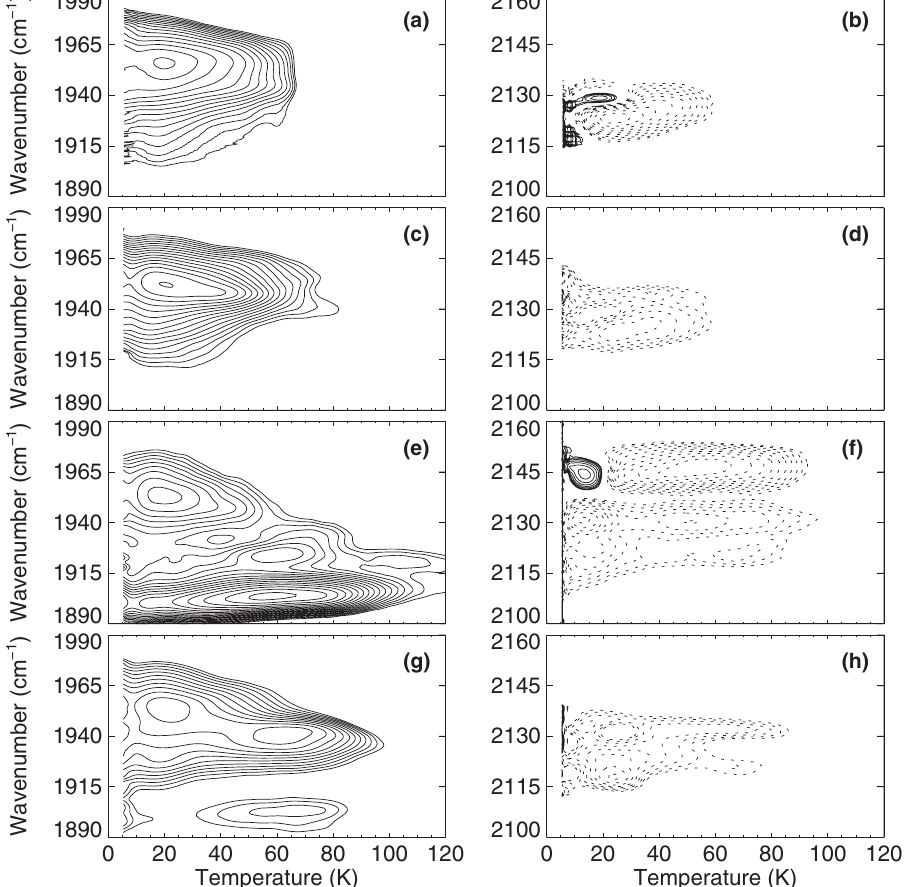
Figure 4. TDS contour maps of iNOS -CO, obtained after constant illumination during slow cooling from 160 to 4 K. Left column: oxy Absorption changes in the bands of heme-bound CO. Right column: Absorption changes in the photoproduct bands. Contours are spaced logarithmically; solid and dotted lines represent increasing and decreasing absorption, respectively. iNOS with H4B; ( e , f ) with L-Arg; ( g , h ) with